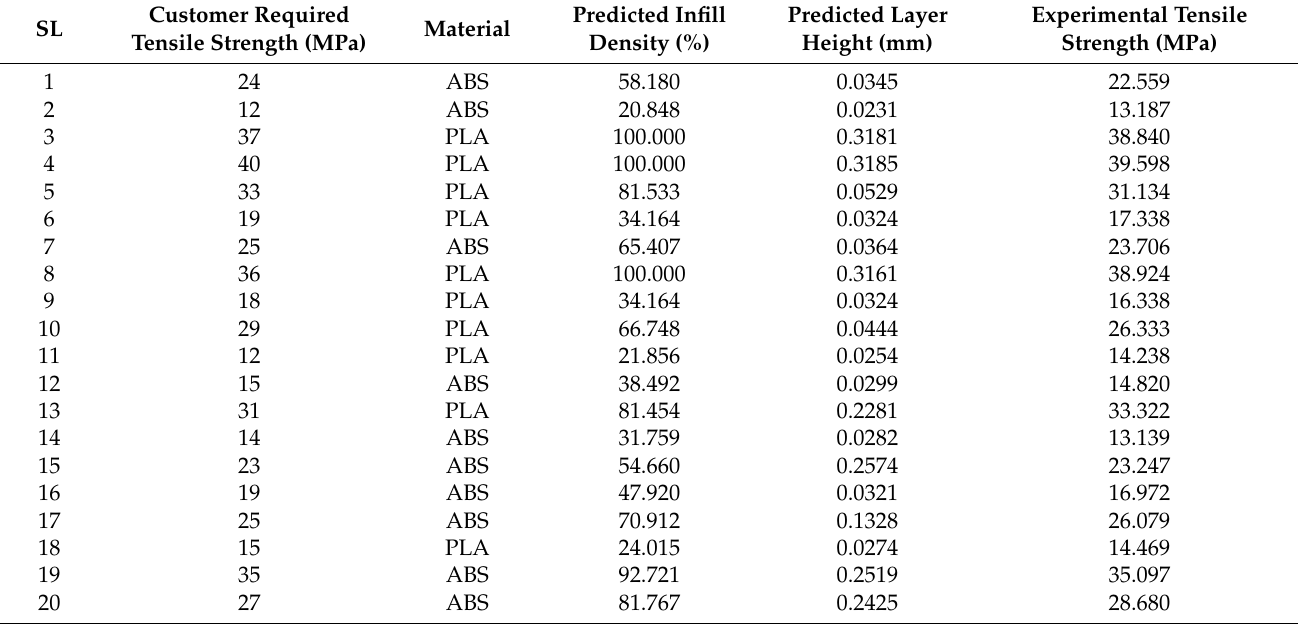
Figure 20. ( a ) Rendered picture of the ASTM D638 specimen with dimensions (using Solidworks software) ( b )Product during printing. Table 6. Customer request data and experimental data with respect to predicted infill